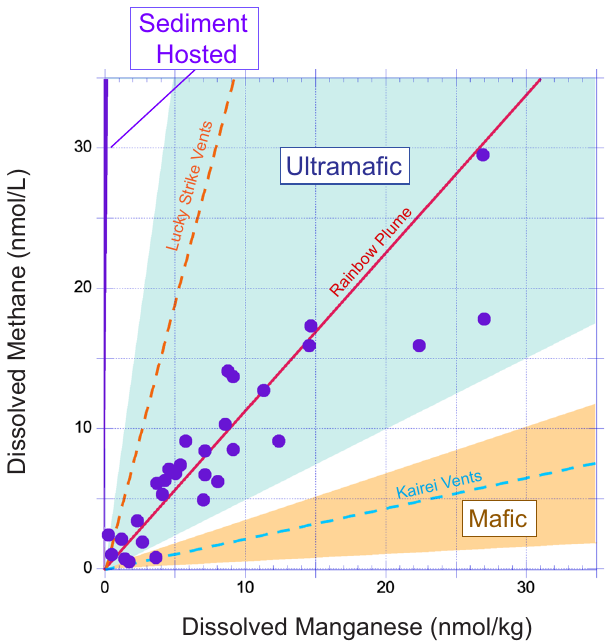
Fig. 4 | Plot of dissolved CH4 concentrations vs dissolved Mn concentrations for the Aurora hydrothermal plume (solid circles) compared with the like-for- like trend (red line) for the Rainbow hydrothermal plume 39 . Ranges of CH 4 :Mn ratios for high temperature ( ≥ 300°C) vent- fl uids at sites hosted in ma fi c rocks on slow and ultra-slow spreadingridges (Snakepit,TAG, BrokenSpur and Piccard) are showninpaleorange(datafrom 59,70,71 ).Correspondingrangesforhightemperature ( ≥ 300°C)ventsin fl uencedbyultrama fi crocks(Rainbow,LogatchevI,LogatchevII, Ashadze I, Ashadze II) are shown in pale blue (data from 33,71,72 ). Also shown, in purple, are the much higher CH 4 :Mn values for systems in fl uenced by terrigenous continental sediments of the kind reported at Aurora (ref. 40 and reference. therein).Thedashed orangeline(LuckyStrikeVents 73 )anddashed blue line(Kairei Vents 36 )indicatetwovent-systemsthatdepartfromthegeneralcase,eachofwhich is discussed in detail in the